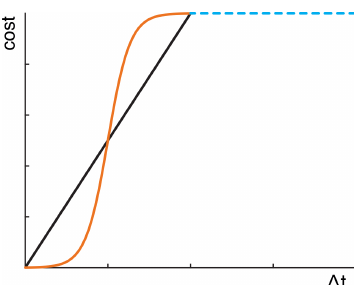
Figure 5. Linear cost function for shifting (black) and alternative, nonlinear cost function